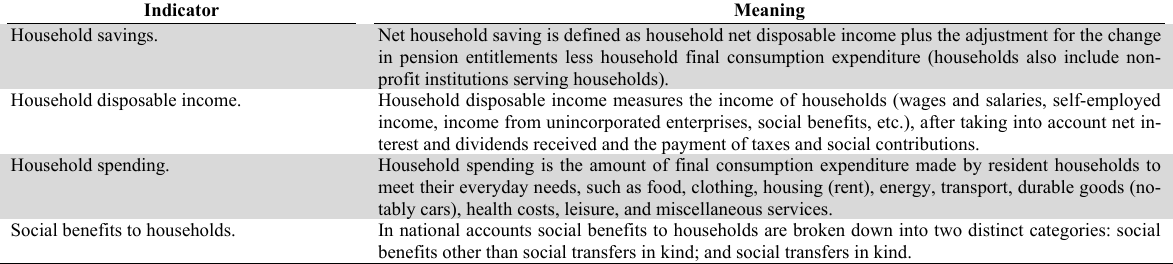
Indicator Meaning Household savings.